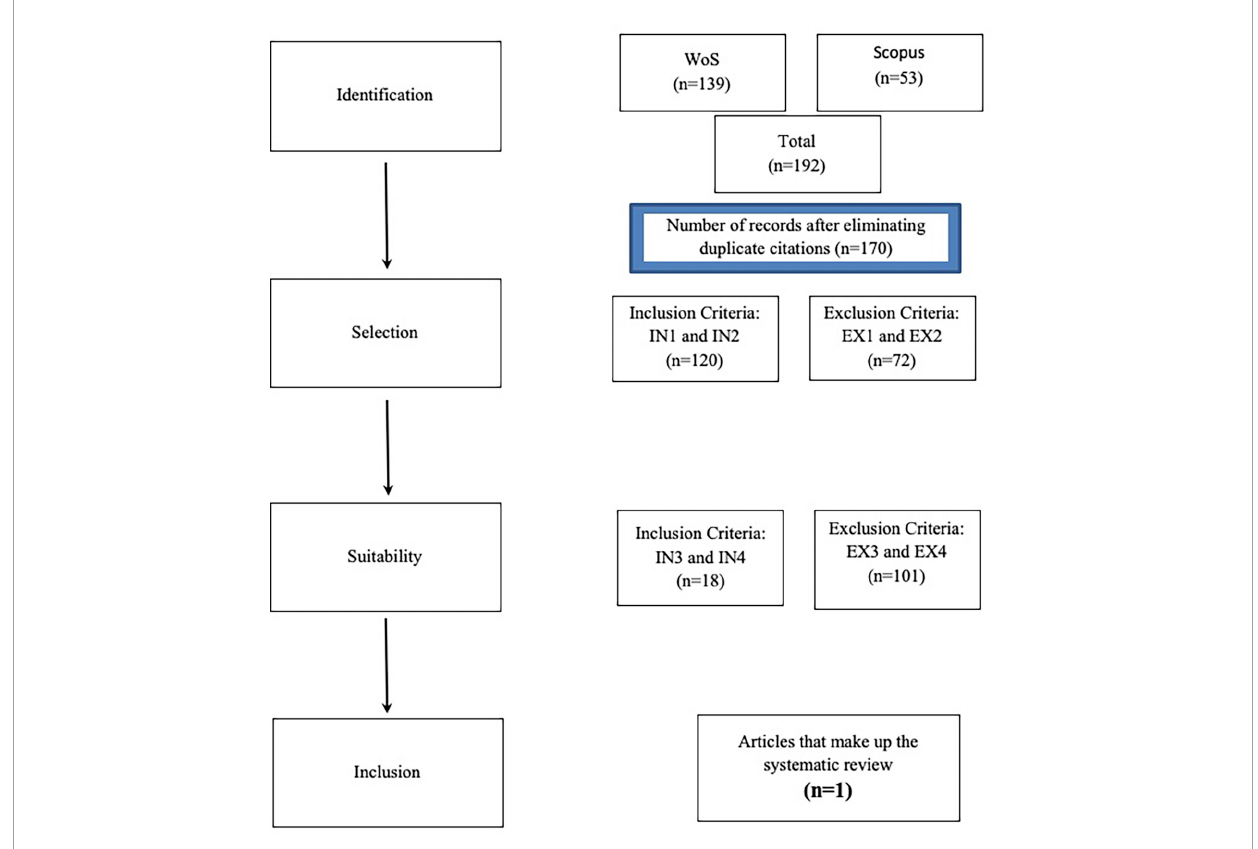
FIGURE1 Flow chart. Source: Own elaboration based on Moher et al.